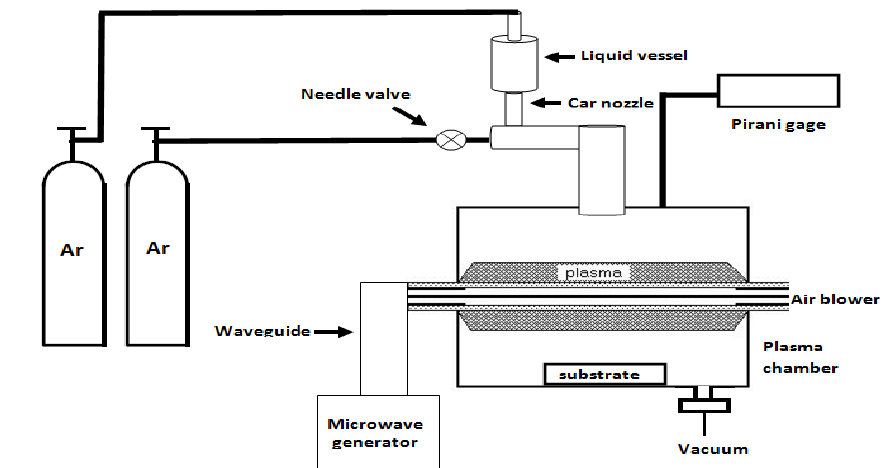
Fig. 1: Schematic diagram for microwave induced plasma system for nanocomposite thin films